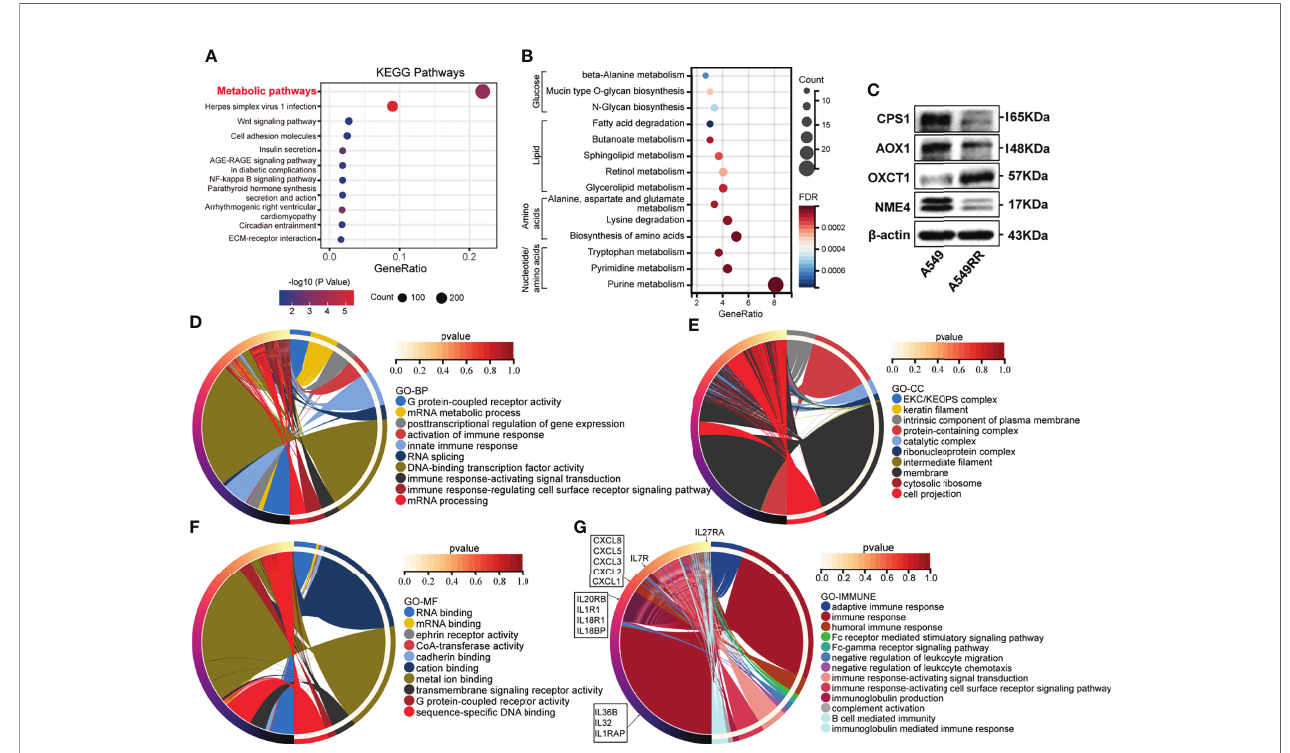
FIGURE 1 | The function enrichment of differentially expressed genes (DEGs) between radioresistant (A549RR) and its parent cells (A549). (A, B) Results of Kyoto Encyclopedia of Genes and Genomes (KEGG) pathway enrichment (p < 0.05). The color of the node was counted by p-value, and more signi fi cant enrichment was shown with greater node size. (C) Expression of metabolic-related protein in A549 and A549RR cells measured by western blot. (D – F) Results of gene ontology, including biological process (BP), molecular function (MF), and cellular component (CC) were mapped using R package circlize (p < 0.05). Among the groups, the representative term and lag were highlighted by different colors. (G) Differences immune system process and related genes were mapped using R package circlize. The representative term and lag were highlighted by different colors. (p <